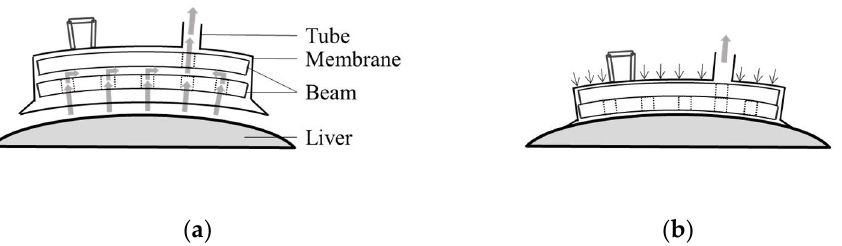
Figure 2. Structure and basic of the organ-grasping device. ( a ) The device in a low-stiffness state. ( b ) The device in a high-stiffness state.